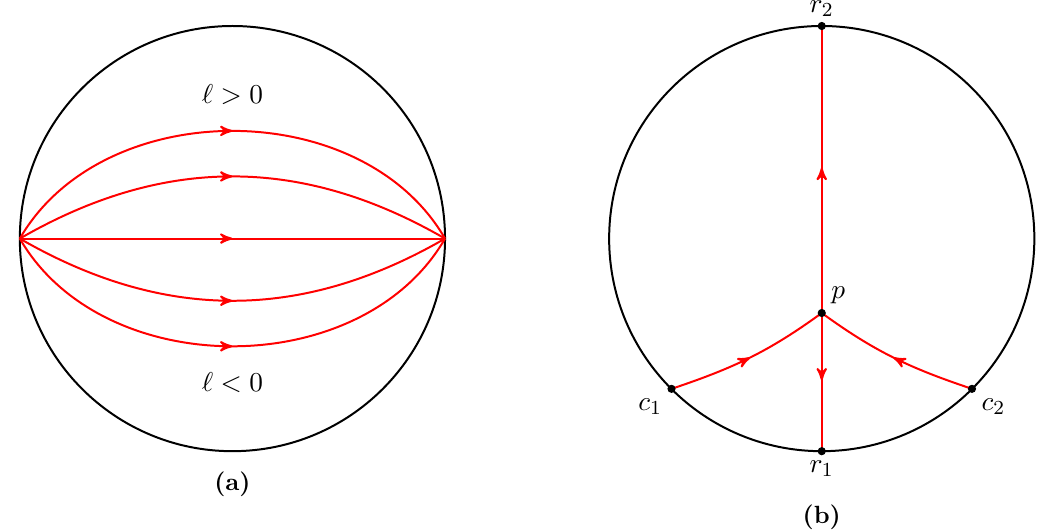
Figure 12. a) Projection of null lines in pure global AdS onto a constant time slice. Null lines always begin and end at antipodal points, and their angular momentum ‘ controls their path. b) Projection of the minimal time paths connecting a central point p with the input and output points. From symmetry, only ‘ , the angular momentum of one of the incoming null lines, is left to optimize